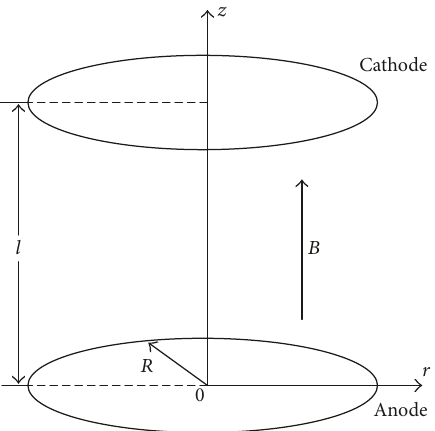
Figure 1: Schematic of a glow discharge with external magnetic